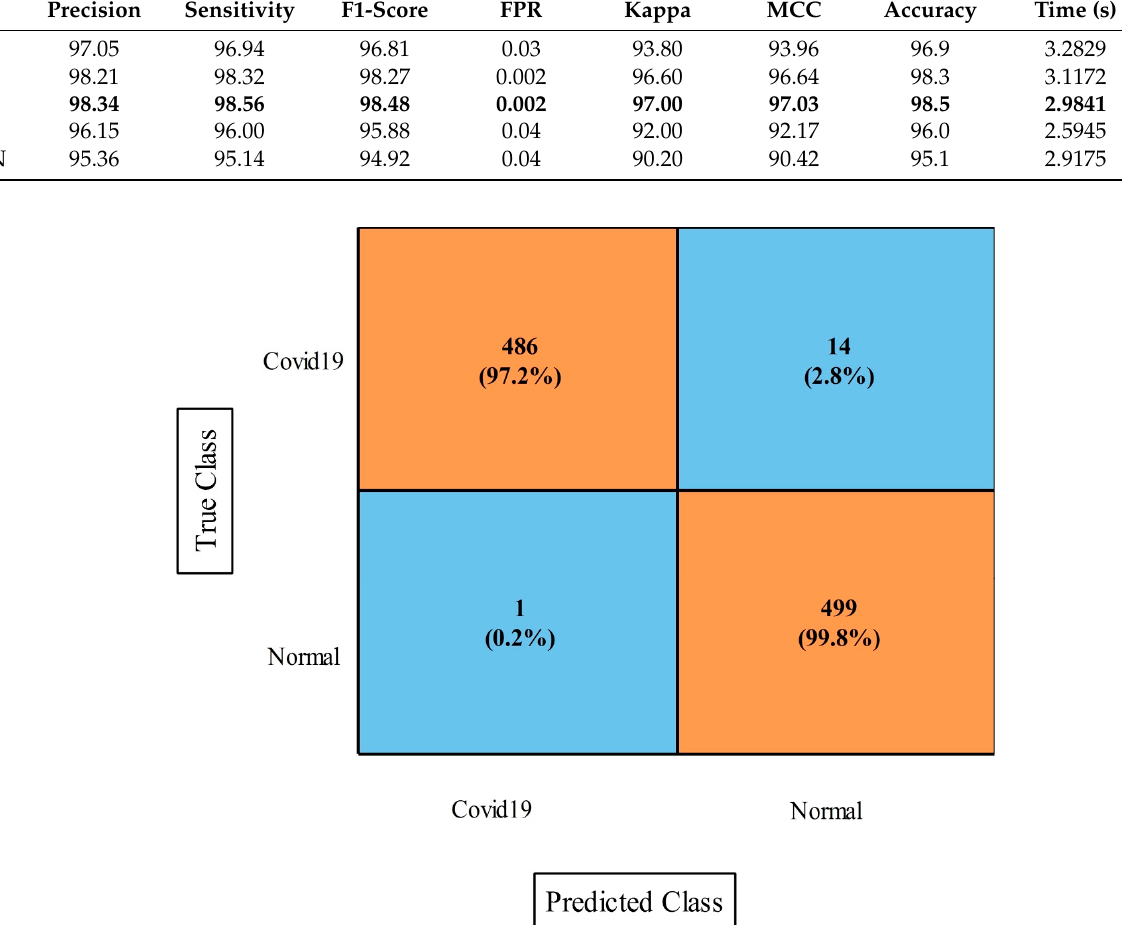
Figure 8. Proposed fusion approach confusion matrix for WNN classifier on COVID-19 Patients Lungs X-ray dataset.